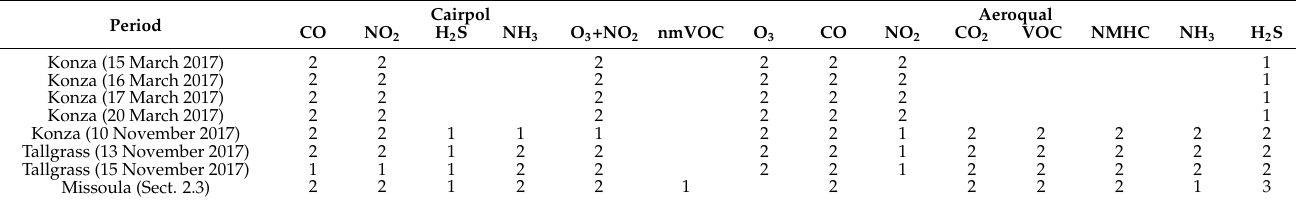
Table 3. Number and type of sensors used for each study